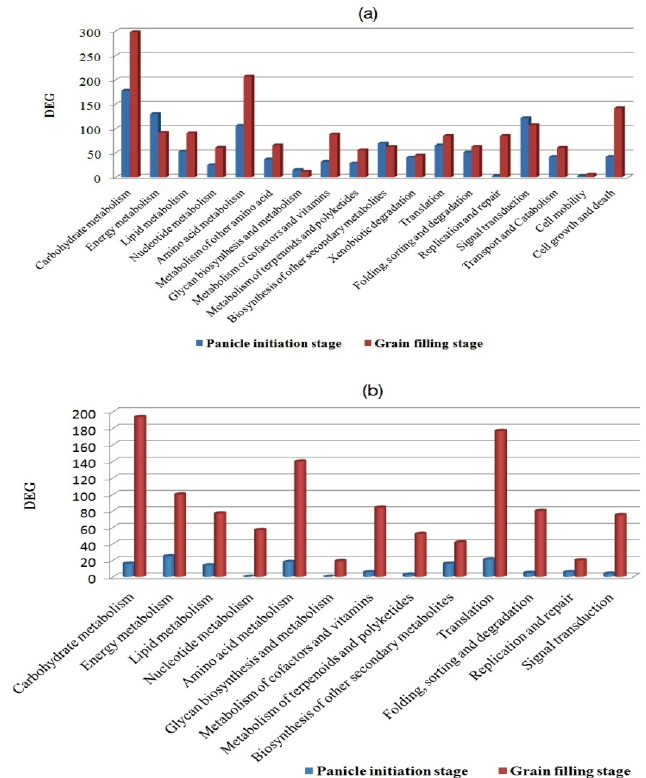
Figure 2. Comparison of Gene Ontology (GO) functional sub-categories of panicle initiation and grain filling stage in two rice hybrids ( a ) Ajay and ( b ) Rajalaxmi.